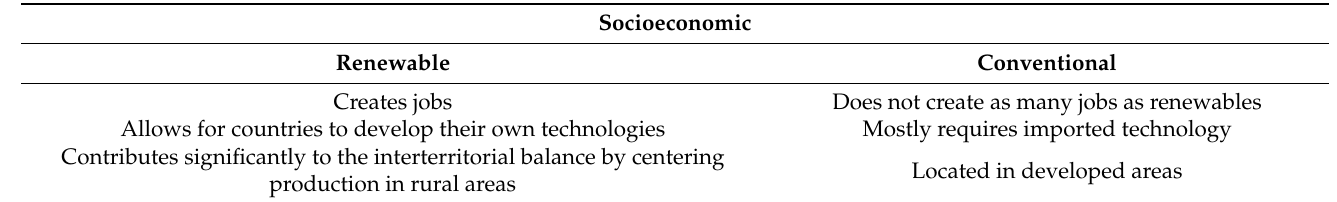
Table 3. Socioeconomic